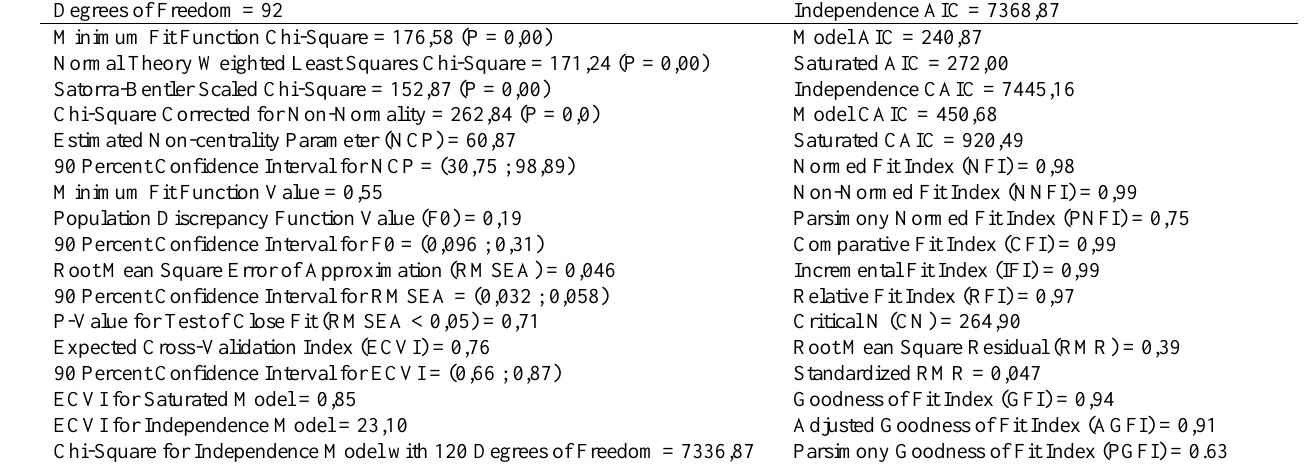
Table 5: Goodness of fit statistics for the learning potential structural model (after third modification) Degrees of Freedom = 92 Independence AIC = 7368,87 Minimum Fit Function Chi-Square = 176,58 (P = 0,00)